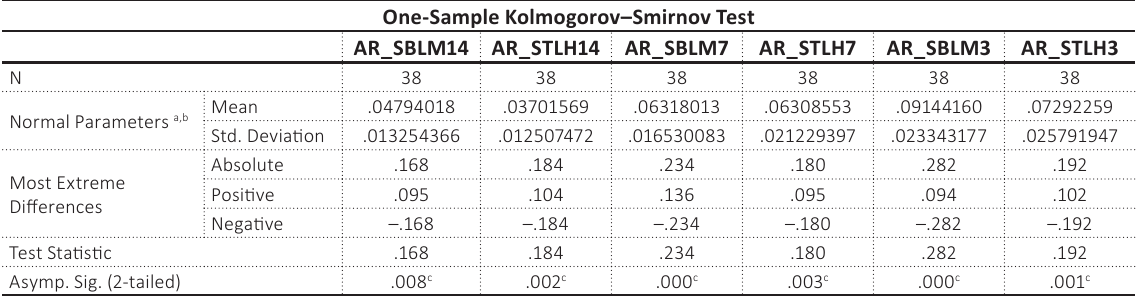
Table 3. Normality test of trading volume activity variables